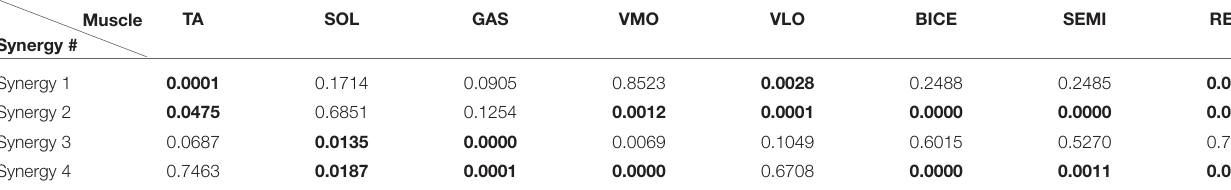
TABLE 2 | The p -values between muscle synergy W with ∈ R 4 × 8 and W without ∈ R 4 × 8 , p ≤ 0.05 indicates significant difference in statistics. Muscle Synergy #